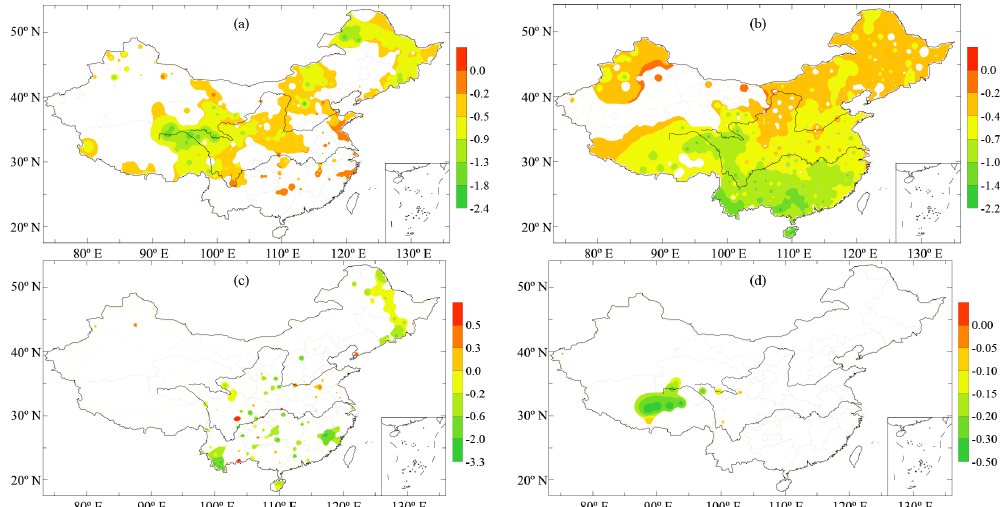
Figure 10. Spatial trend of annual number of high-impact weather spells in China during 1959–2014 (unit: times decade − 1 ; (a) snowfall spells, (b) thunderstorm spells, (c) foggy weather spells, (d) hailstorm spells).